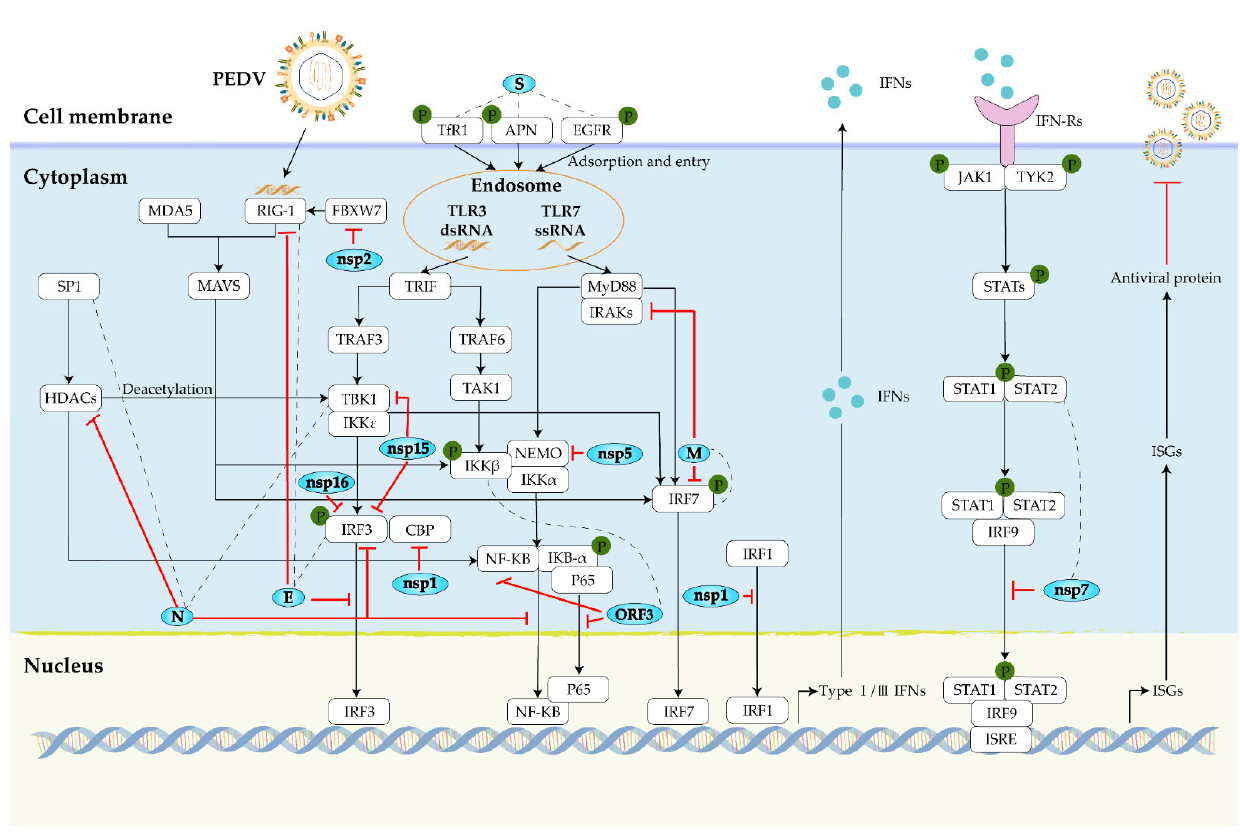
Figure 3. Schematic diagram of PEDV evading the host innate-immune signaling pathway. On the one hand, PEDV infection activates the host innate-immune signaling pathway. On the other hand, PEDV proteins exert inhibitory effects at different stages of the host innate immune response. Interaction of PEDV components with host proteins is indicated by dotted lines; downstream activation is indicated by black arrows; inhibition or degradation of target genes is indicated by red lines ending in dashes.